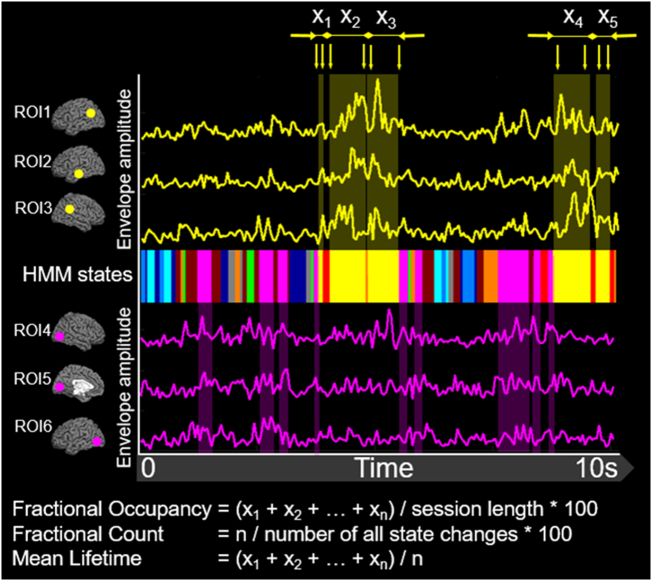
Sample data obtained in a CH participant during a 10s-long time-interval. A multicolored band in the center shows a sequence of network states inferred by the HMM; 10 different colors correspond to 10 states characterized by distinct spatial patterns of the brain oscillatory activity. Note, the timing of the HMM state shown in yellow coincides with increases in the envelope amplitude time-courses shown in yellow in the upper pane. It so happens that all these time-courses were extracted from the known nodes of the DMN, as is shown on the top/left (loci in the cerebral cortex are represented by yellow dots). In contrast, visits to the HMM state shown in magenta are temporally concordant with rises in the envelope amplitude time-courses shown in magenta in the lower pane. It so happens that these time-courses were extracted from the known nodes of the VisN, as is shown in the lower left (loci are represented by magenta dots). Several temporal metrics of the inferred HMM states can be computed. For instance, given that the yellow state (labeled DMN) was visited n number of times during the recording session, and the visits lasted for x1, x2, … xn ms, fractional occupancy, fractional count, and mean lifetime can be computed for this state as shown in the bottom.